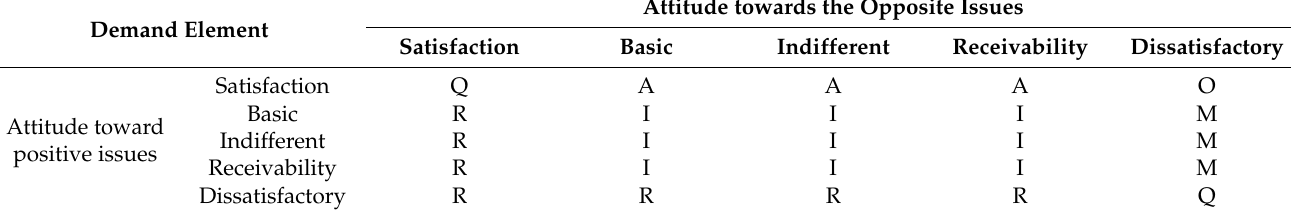
Table 1. Kano model requirements: qualitative